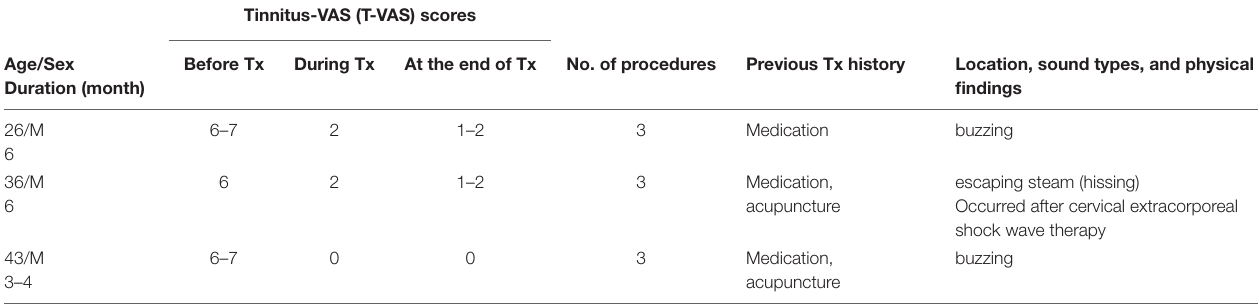
TABLE 5 | Demographic data, visual analog scale (VAS) scores, and clinical data in excluded subacute tinnitus patients. Tinnitus-VAS (T-VAS) scores